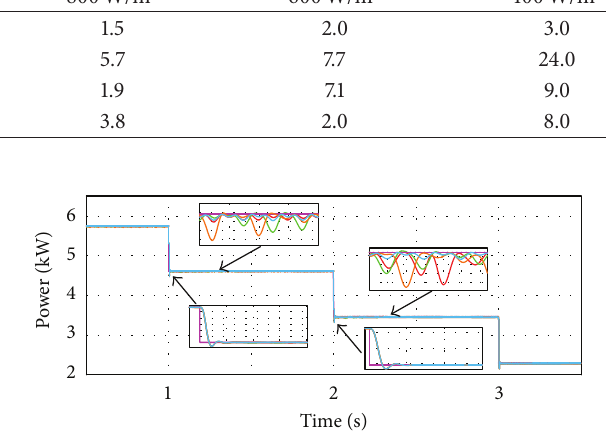
Figure 12: Maximum power extracted and theoretical power during a fluctuation in solar radiation from 1000 W/m 2 to 200 W/m 2 passing through 600 W/m 2 and 400W/m 2 .